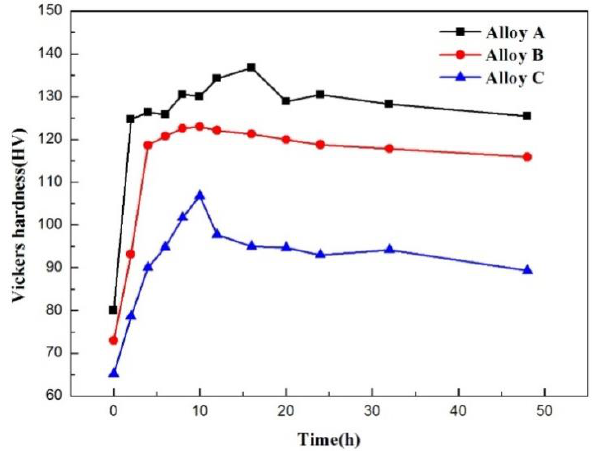
Figure 6. Aging curves of alloys A, B, and C at 225 °C.